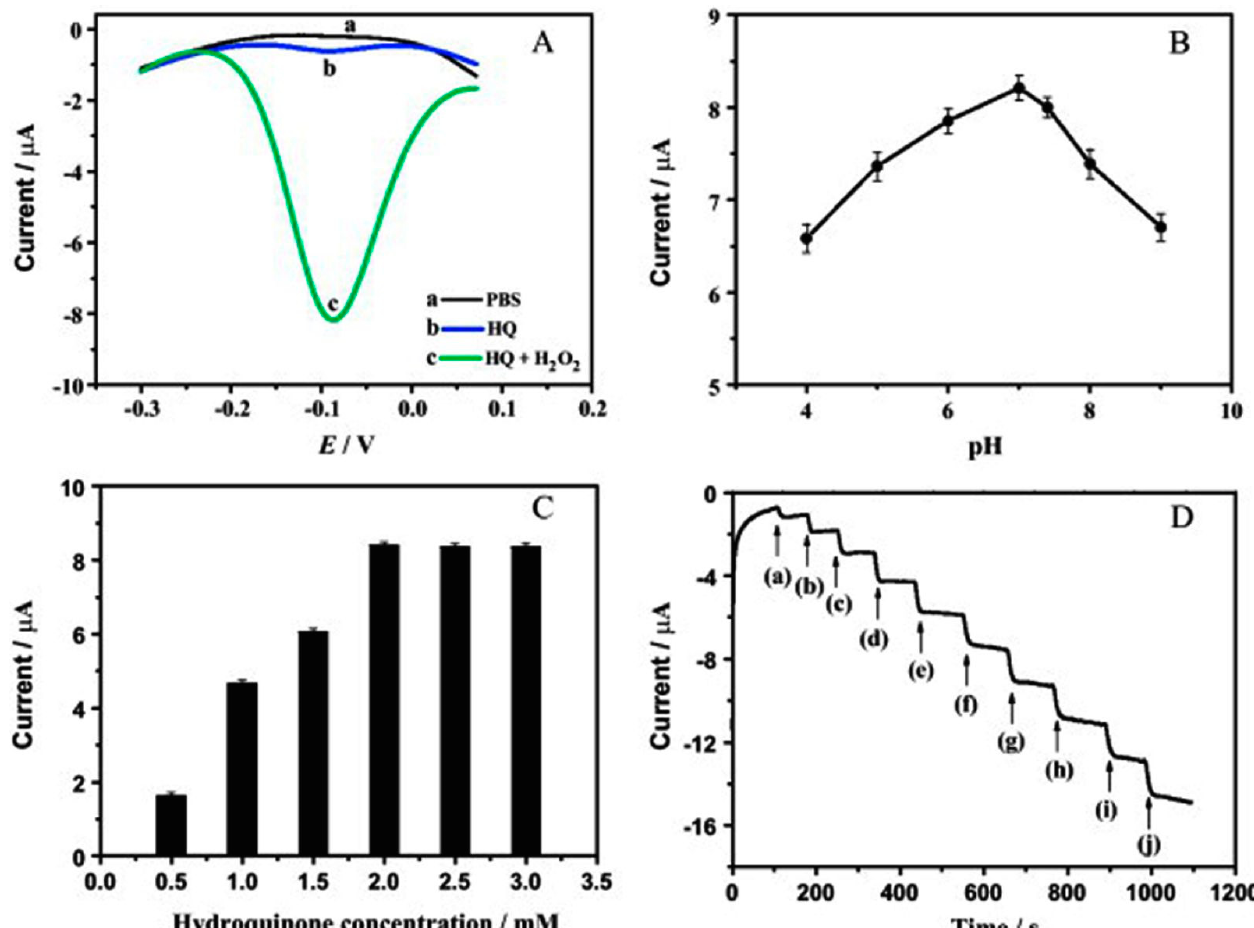
Figure 2. ( A ) Differential pulse voltammograms of an AuMNPs-Apt1/thrombin/Apt2-AuNPs-HRP-modified gold electrode in solution of pH 7.0 PBS containing (a) no H 2 O 2 and hydroquinone (HQ), (b) 2 mM HQ, and (c) 1.5 mM H 2 O 2 + 2 mM HQ. ( B ) The current response of the aptasensor in PBS containing 2 mM HQ and 1.5 mM H 2 O 2 at different pH values. ( C ) The current response of the aptasensor in PBS (pH 7.0) containing different HQ concentrations. ( D ) The current response of the aptasensors in PBS (pH 7.0) at the potential of − 0.2 V while H 2 O 2 was stepwise added into the system. The final concentration of H 2 O 2 reaches to (a) 0.25, (b) 0.5, (c) 0.75, (d) 1.0, (e) 1.25, (f) 1.5, (g) 1.75, (h) 2.0, (i) 2.25, and (j) 2.5 mM. Reprinted with permission from reference [52]. Copyright Elsevier 2011.